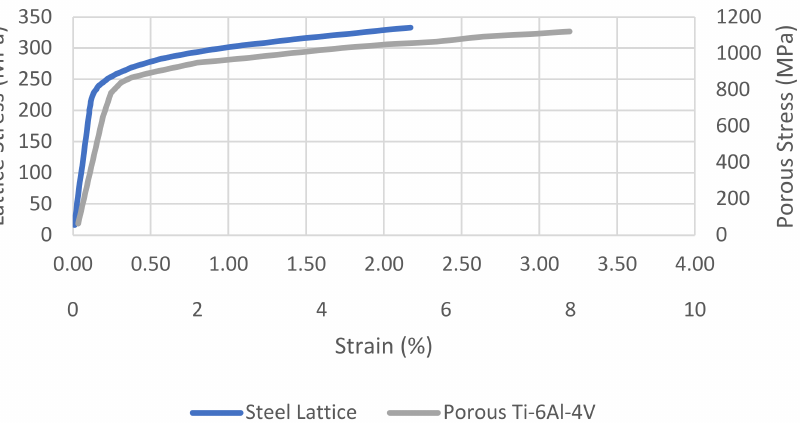
Figure 4. Experimentally measured stress–strain curves for a stainless-steel lattice and porous Ti6AL4V (porosity 7.6%) subjected to tensile loading [13,14] (reconstructed